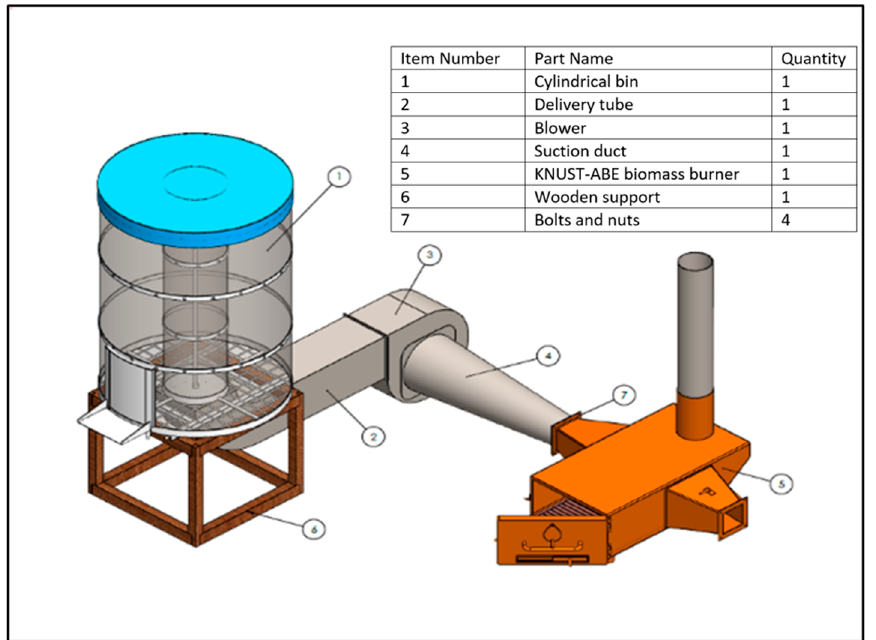
Figure 1. CAD model of the crossflow column dryer showing all of its parts.